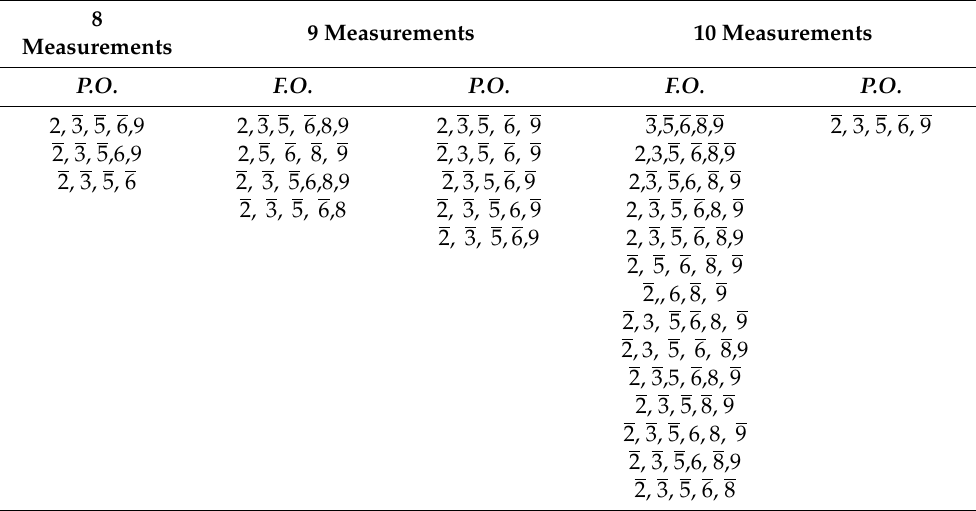
Table 5. All the sets for achieving different levels of observability for 8, 9, and 10 measurements per set. Partial observability (P.O.) and full observability